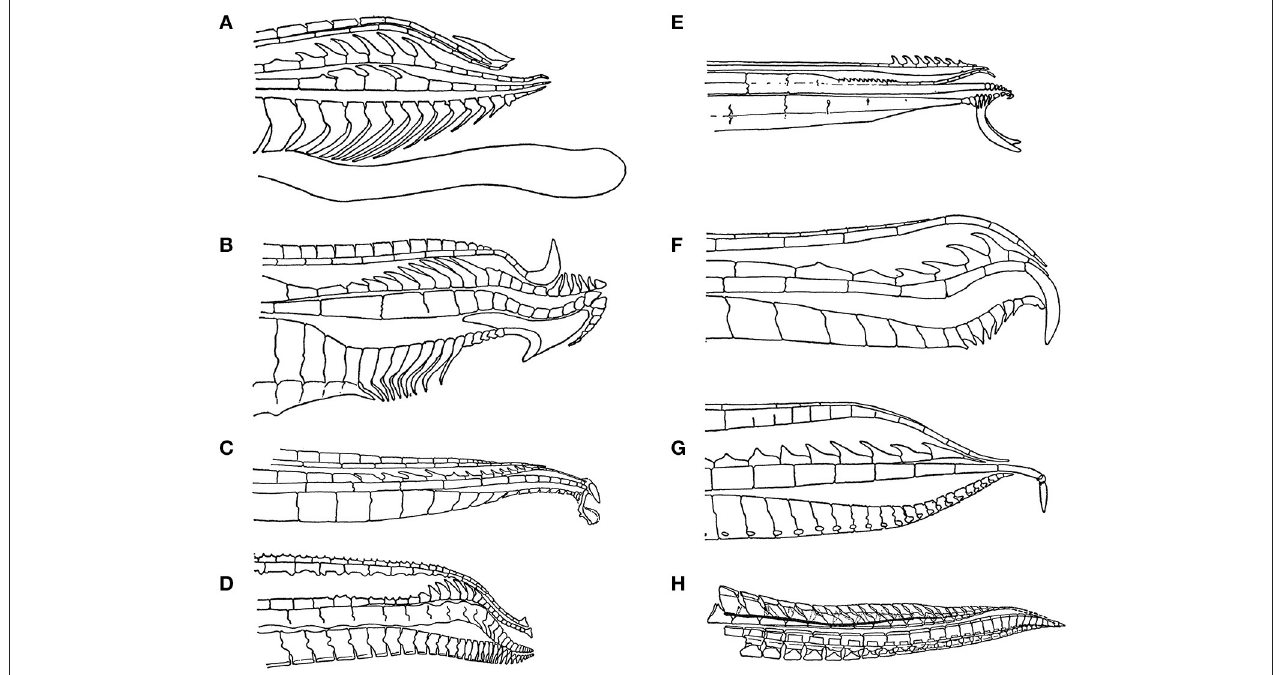
FIGURE 2 | The tip of the male gonopodium, the intromittent organ, exhibits a great deal of variation across the family Poecillidae: (A) Poecilia reticulata , (B) Xiphophorus helleri , (C) Phalloceros caudimaculatus , (D) Belonesox belizanus , (E) Girardinus cubensis , (F) Neoheterandria elegans , (G) Heterandria formosa , and (H) Poeciliopsis elongata . Figures redrawn from Rosen and Bailey